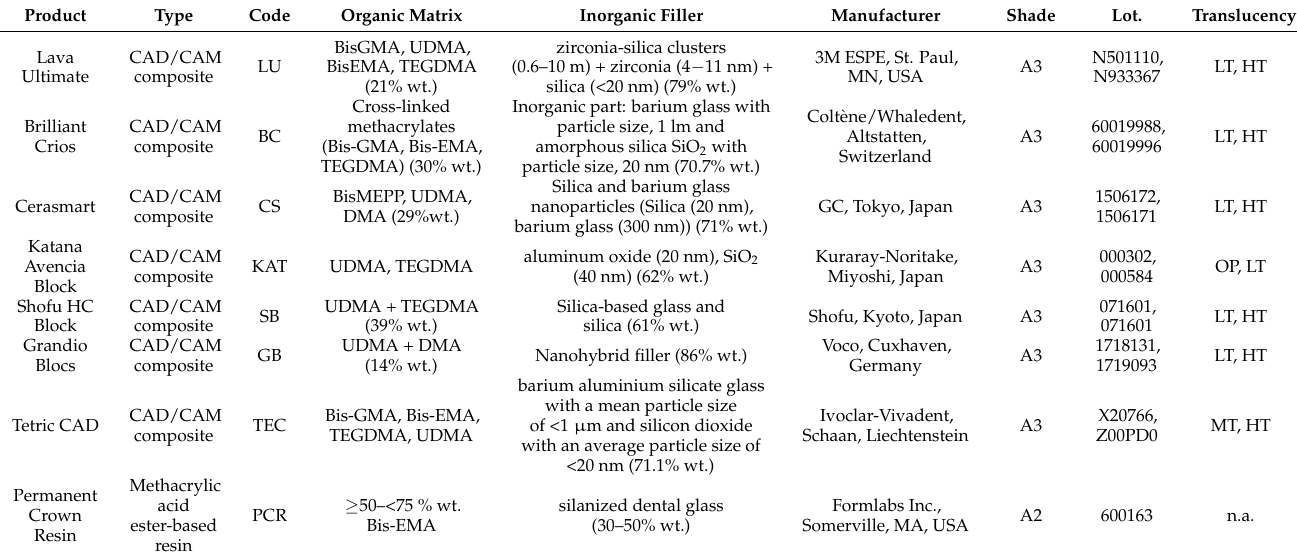
Table 1. Characteristics of the investigated materials.